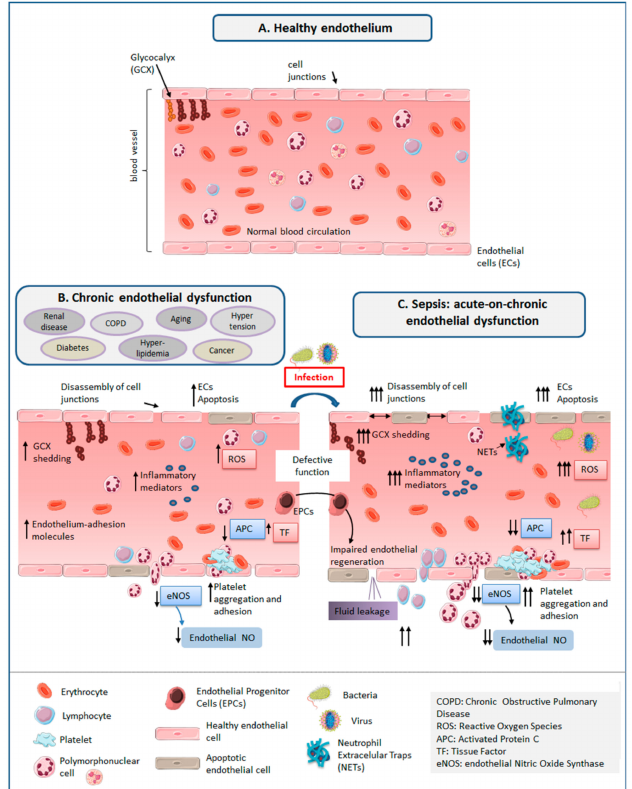
Figure 1. The endothelium in different scenarios: ( A ) Healthy endothelium: the normal vascular endothelium consists of a layer of endothelial cells with the glycocalyx on the luminal side. It prevents microorganisms to enter into tissues, exerting in addition a natural anticoagulant action that prevents from uncontrolled activation of the coagulation system; ( B ) Endothelial dysfunction (ED) induced by aging and chronic disease: senescence and the comorbidities preceding sepsis are associated to the presence of a chronic status of increased oxidative stress and inflammation, which induces glicocalyx degradation, apoptosis of endothelial cells, disassembly of endothelial cell junctions, and increased expression of molecules which promotes leukocyte adhesion to endothelial cells. In turn, these diseases induce a pro-coagulant and anti-fibrinolytic state with diminished activation of protein C and increased production of tissue factor. Decrease in the production of nitric oxyde by the endothelial nitric oxide synthase promotes platelet aggregation and adhesion. Finally, these diseases impair production and function of Endothelial Progenitor Cells, impairing endothelial regeneration; ( C ) ED in sepsis: sepsis induces similar features of ED to those caused by aging and chronic diseases, inducing oxidative stress and inflammation, release of NETs and proteases by neutrophils, leading to fluid and cell leakage, hypotension, microvascular thrombosis, inadequate organ perfusion, organ failure and shock in the most severe cases. In addition, bacterial toxins can breach the endothelial barrier, by directly killing endothelial cells (ECs), weakening the cytoskeleton within ECs, and breaking the junctions between ECs. Acute challenges such as the aggression induced by surgery, trauma or hypervolemia could contribute to facilitate or enhance ED in patients facing an infection. Images for representing cells were taken from “Smart Servier Medical Art” (https://smart.servier.com/). NO: nitric